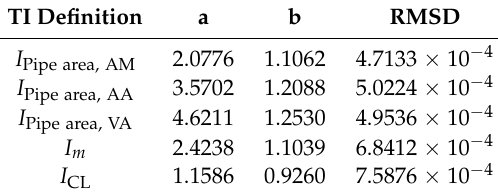
Figure 8. TI as a function of v τ / v m . Table 6. Power-law fit constants.